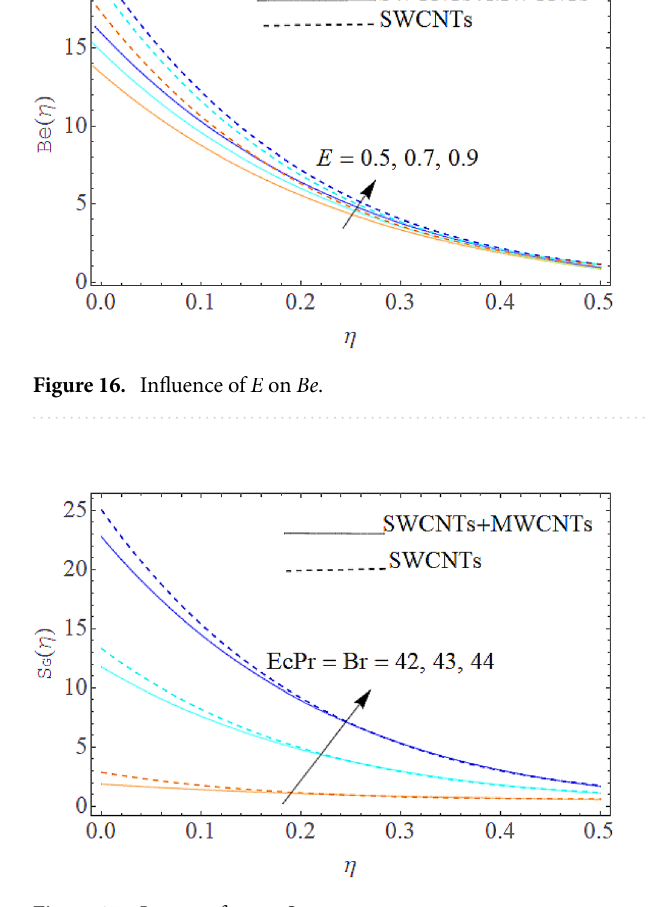
Figure 17. Impact of Br on S G .